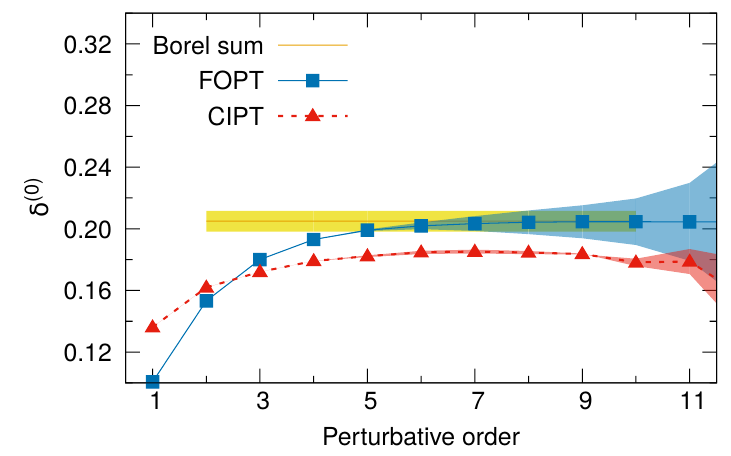
Figure 2: Final results for δ ( 0 ) in QCD. The bands in the perturbative expansions stem from the uncertainty in the coefficients, while the band in the sum of the series is from the spread in the values from different PAs (see last columns of Tabs. 1 and